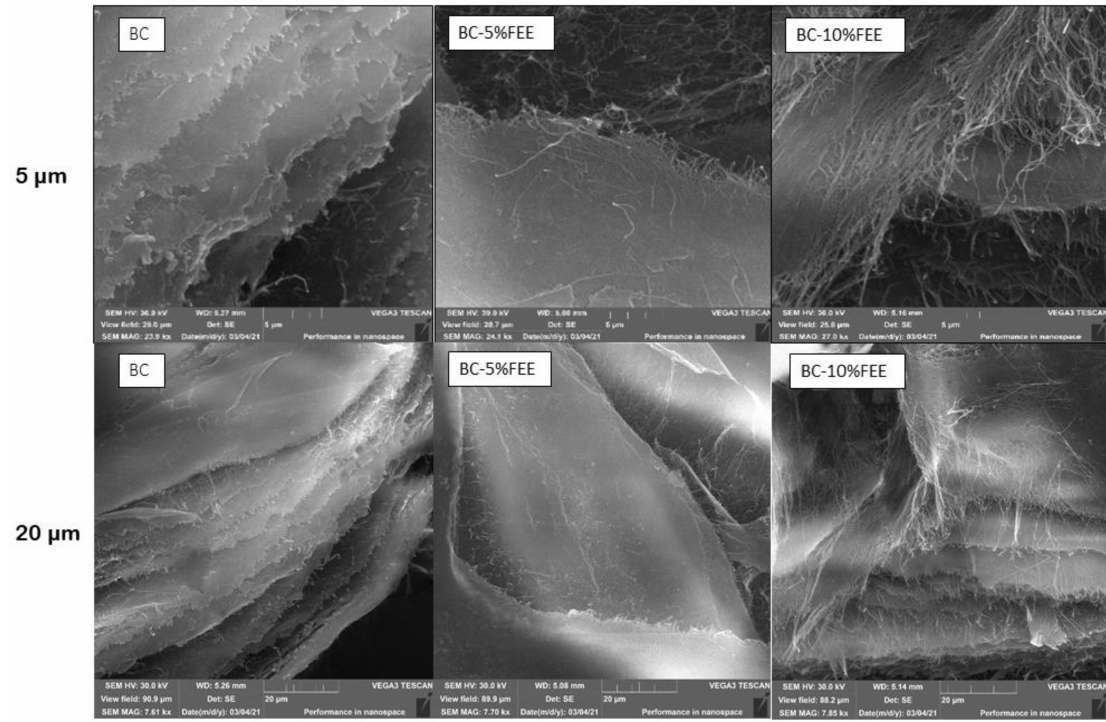
Figure 6. The SEM micrographs of BC, BC-5%FEE, and BC-10%FEE on a scale of 5 and 20 µ m.